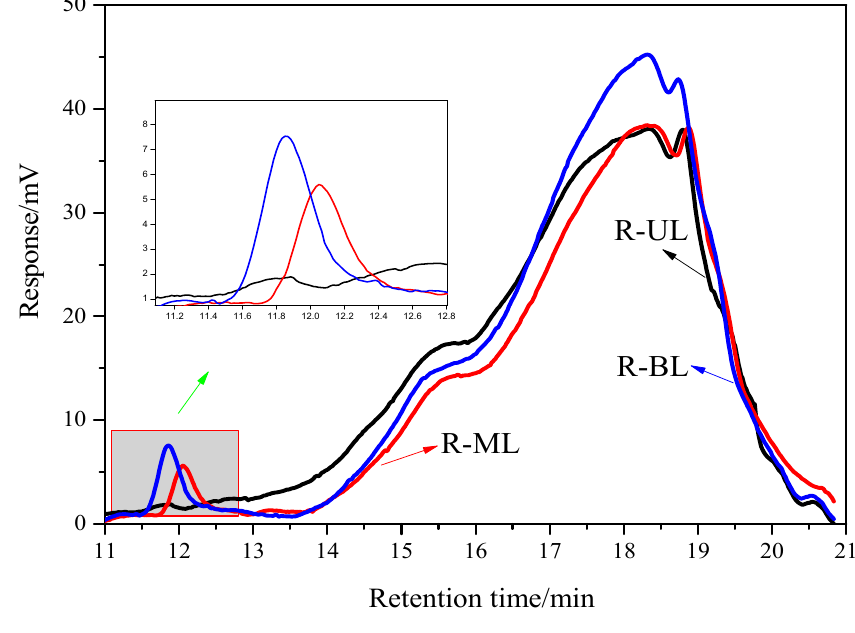
Figure 5. GPC curves of bitumen from R-UL, R-ML, and R-BL. 157